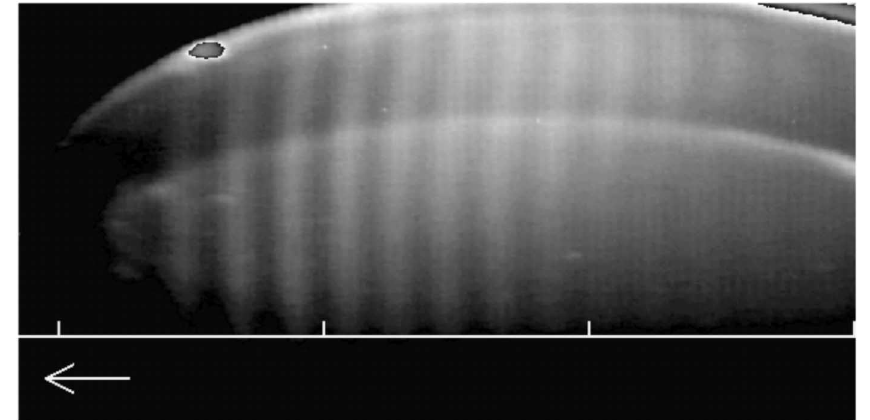
FIG. 5. A gray-scale image of 60 m m FIREFLY microbunches focused in the energy spectrometer. The energy distribution of the final beam, dispersed horizontally in this image, exhibits the time profile of the beam at the undulator exit. The light colored vertical bars are regions of higher electron density (microbunches). The two horizontal white arcs are optical artifacts (reflections from the edge of the scintillator). The scale and arrow at the bottom of the image indicate picoseconds and the direction of bunch travel.